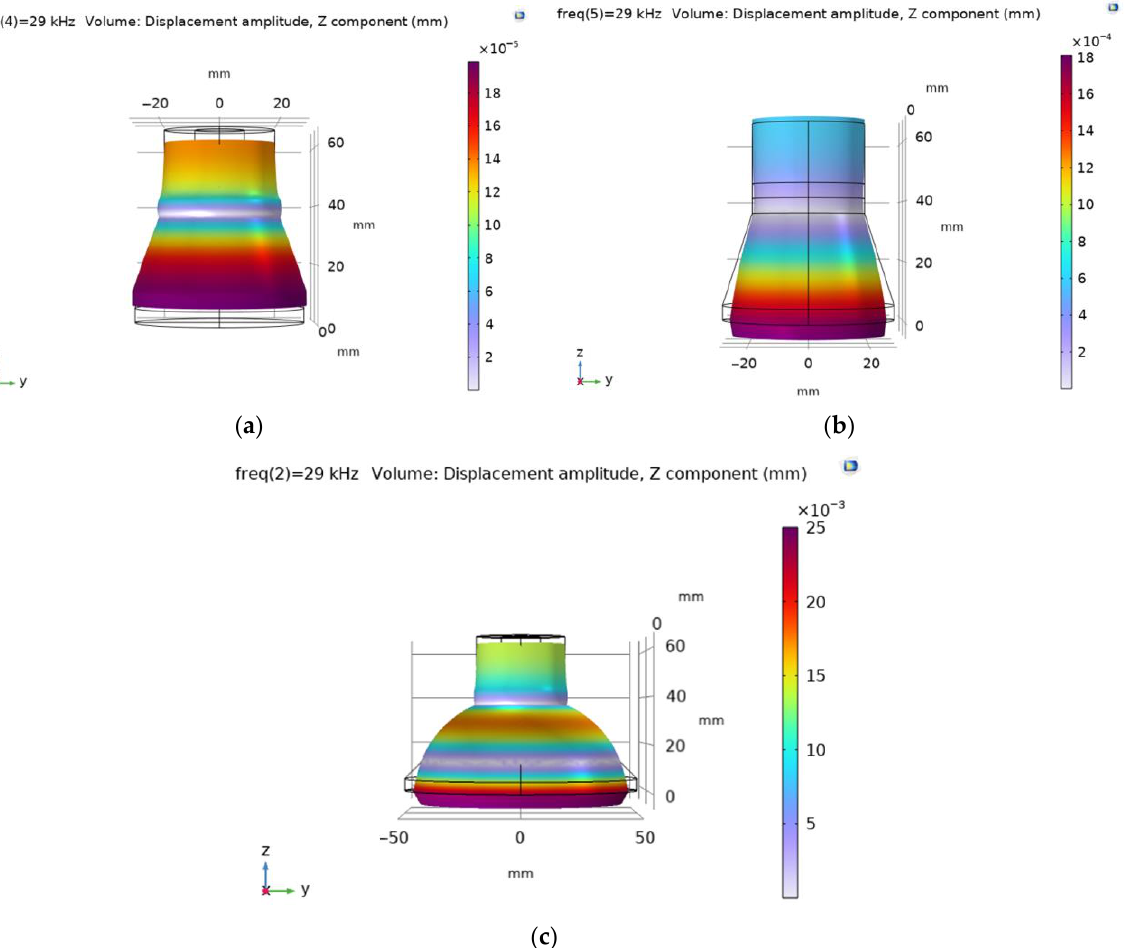
Figure 5. Modal shapes of the piezoelectric transducer at the first natural frequency: ( a ) with flat surface; ( b ) with 58 mm diameter ring-shaped surface; ( c ) with 100 mm diameter ring-shaped surface.